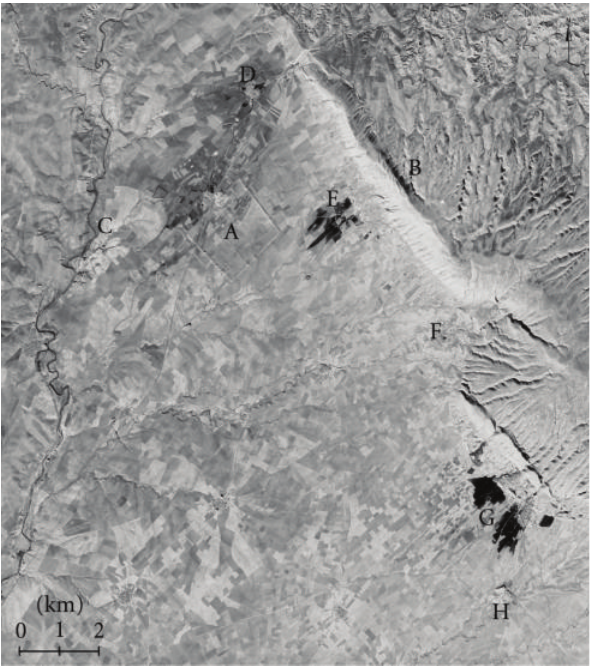
Figure 13: The territory of Dur-Sharrukin in a Corona KH-4B photo of 1969: the urban area of the capital city (A), Jebel Bashiqa (B), Khosr River (C), springs at Barima (D), Fadhiliya (E), ’Ain Bahr (F) and Bashiqa (G), and the ancient settlement of Tell Billa (H) are shown.